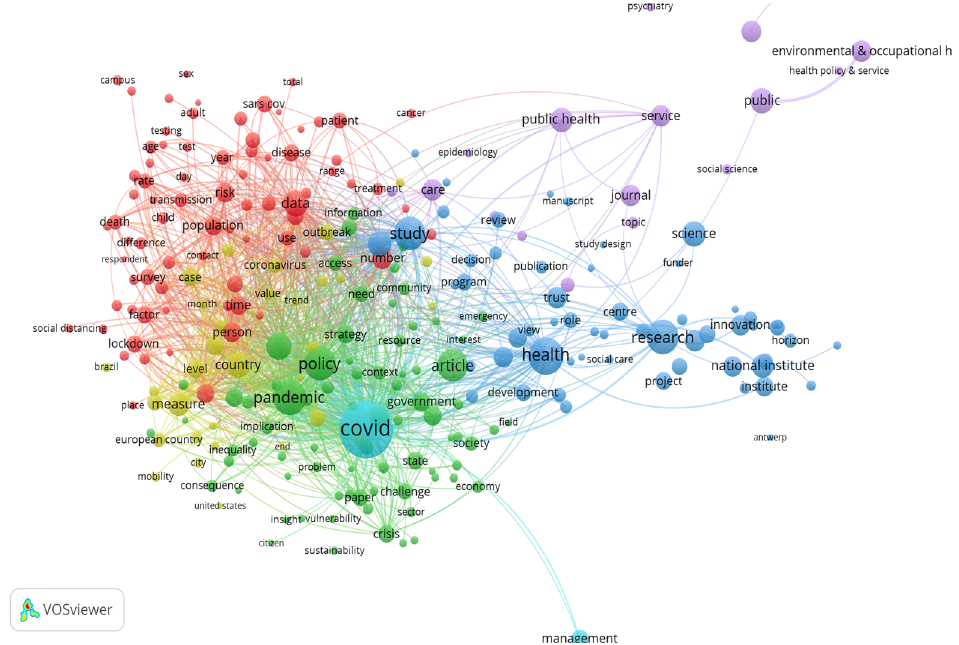
Figure 3. Most common words and word network in scientific publications’ content. Source: Authors’ selection from WoS database, based on selected words, using VOS programme.